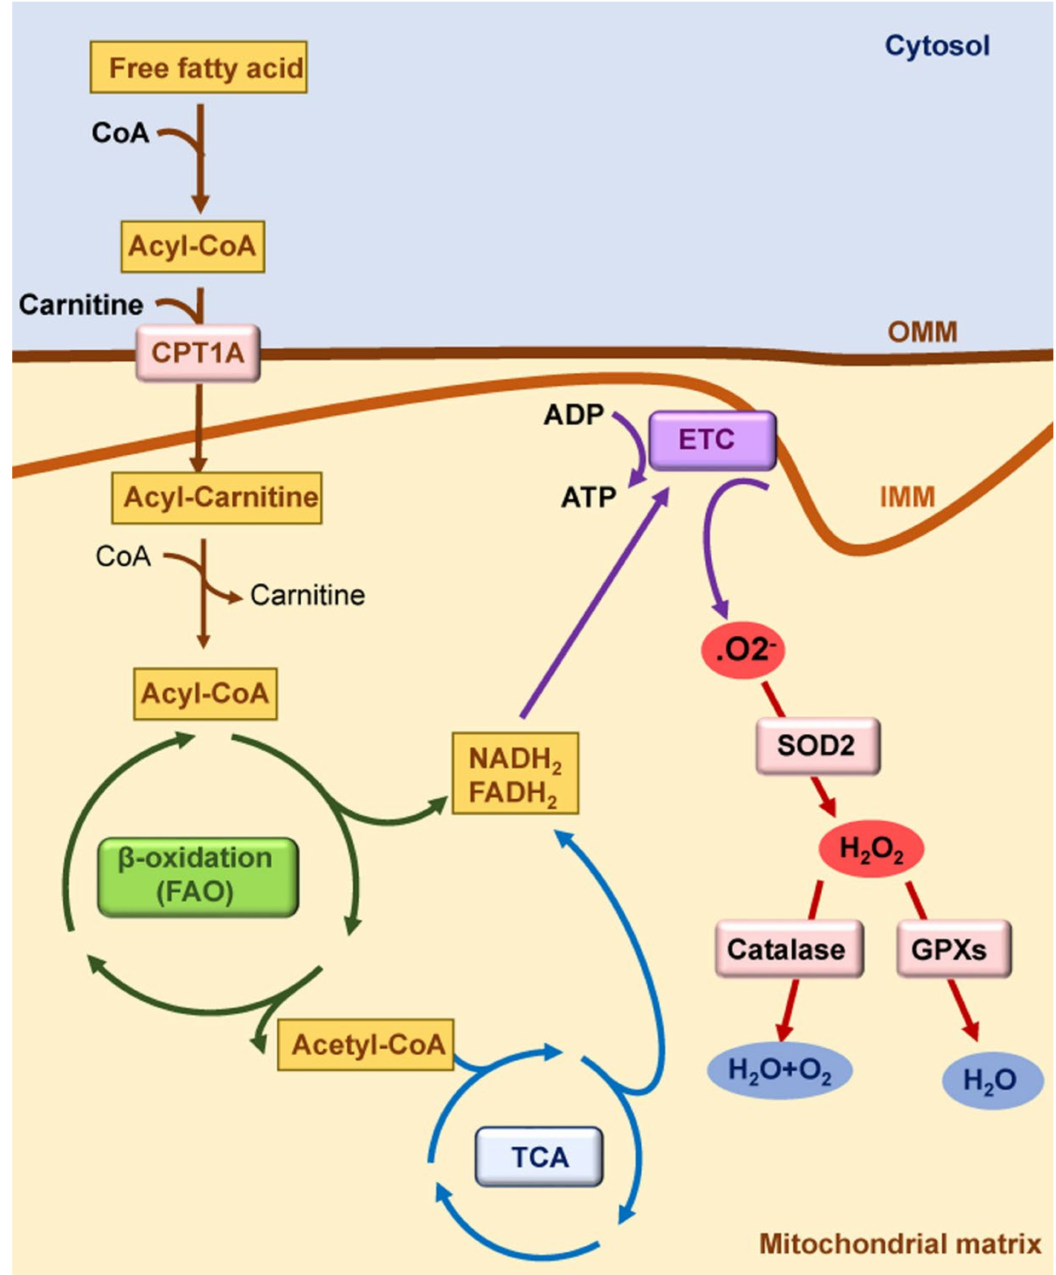
Figure 1. Mitochondrial function in healthy kidneys. Mitochondrial fatty acid β -oxidation (FAO) is the preferred pathway to generate ATP in kidney tubules. Fatty acids are converted in acyl-CoA in cytosol; they are conjugated with carnitine in the outer mitochondrial membrane (OMM) by carnitine palmitoyl-transferase 1A (CPT1A) to cross the inner mitochondrial membrane (IMM). In the mitochondrial matrix, acyl-carnitine is reconverted to acyl-CoA, and it enters the tricarboxylic acid (TCA) cycle. Reduced nicotinamide adenine dinucleotide (NADH 2 ) and reduced flavin adenine dinucleotide (FADH 2 ) generated by FAO and by the TCA cycle deposit their electrons into the electron transport chain (ETC). Electrons released by the ETC react with oxygen to form superoxide anion (O 2 − ), which is converted to hydrogen peroxide (H 2 O 2 ) by superoxidase dismutase 2 (SOD2). H 2 O 2 can be reduced to water by antioxidant enzymes such as catalase and glutathione peroxidases